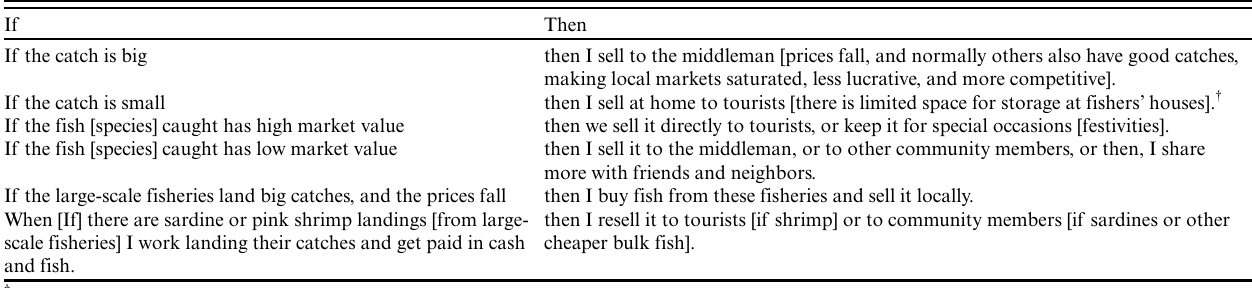
Table 5 . “If, then” strategies adopted by households. Adult and older fisher